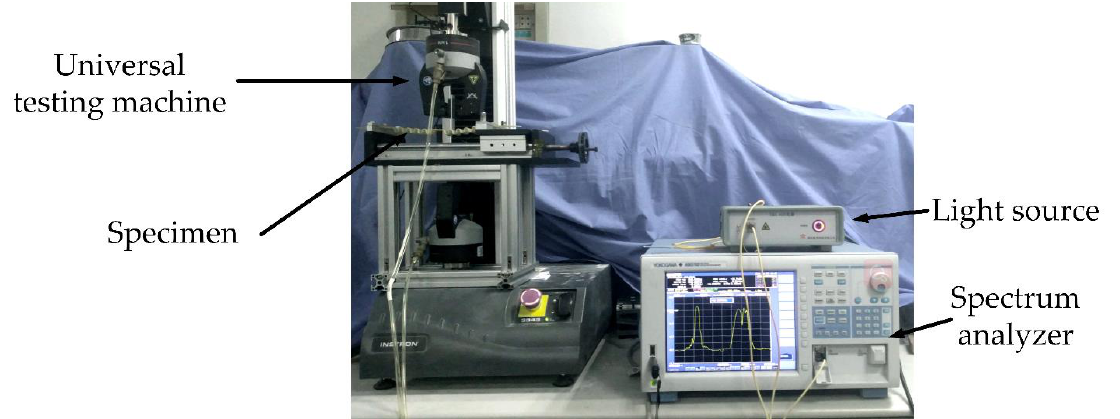
Figure 3. Picture of the experimental setup.